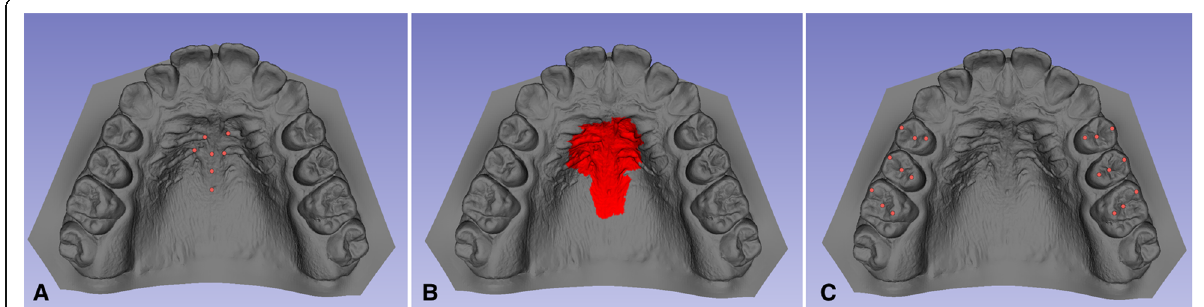
Fig. 2 A Seven landmarks were used for landmark registration on the palatal rugae. B Region of interest around the seven landmarks used for ROI registration. C Landmarks used for dental